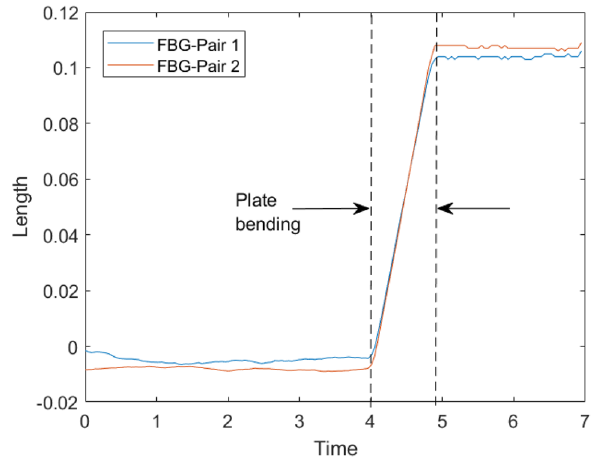
Fig. 3 Change in zone length L sensor between two FBGs due to the plate undergoing static bending